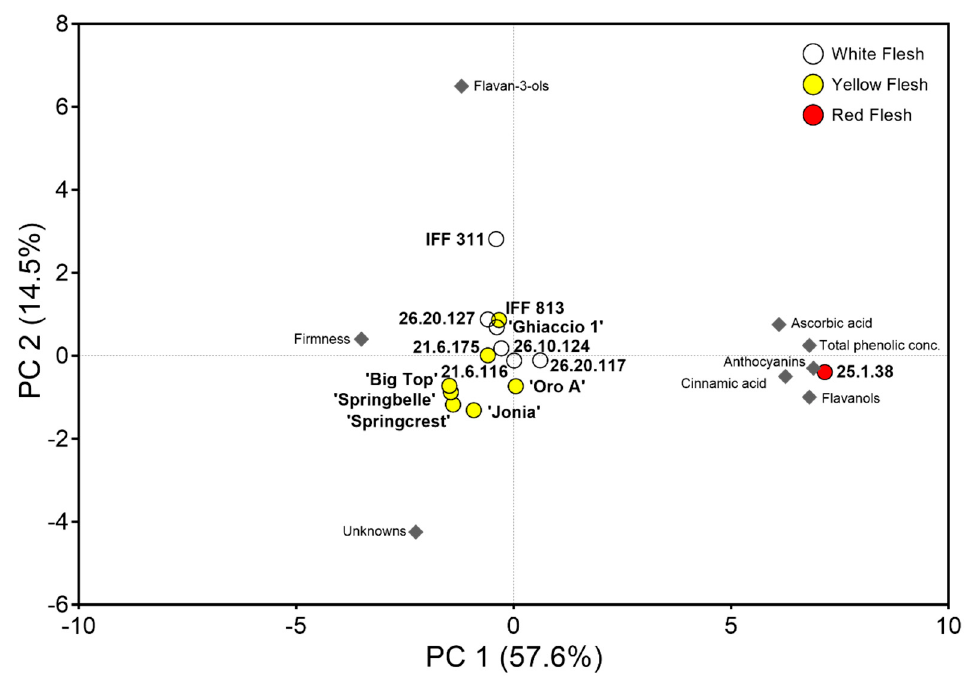
Figure 6. Principal component analysis (PCA) of flesh characteristics on mesocarp quality and phenolic groups. Large circles (scores) visualize the 14 cultivars, colored according to their flesh coloration (yellow, white and red). Grey diamonds indicate the averaged loadings of quality and phenolic data used in the PCA. The scores and loadings are scaled. PCA showcases that flesh coloration (red flesh, in particular) was a major contributor for variation amongst accessions with ~58% of the variation explained on PC1. Additional variation is explained along PC2 (~15%) with flavan-3-ol and unknown compositions appearing to drive vertical separation amongst yellow / white flesh selections.